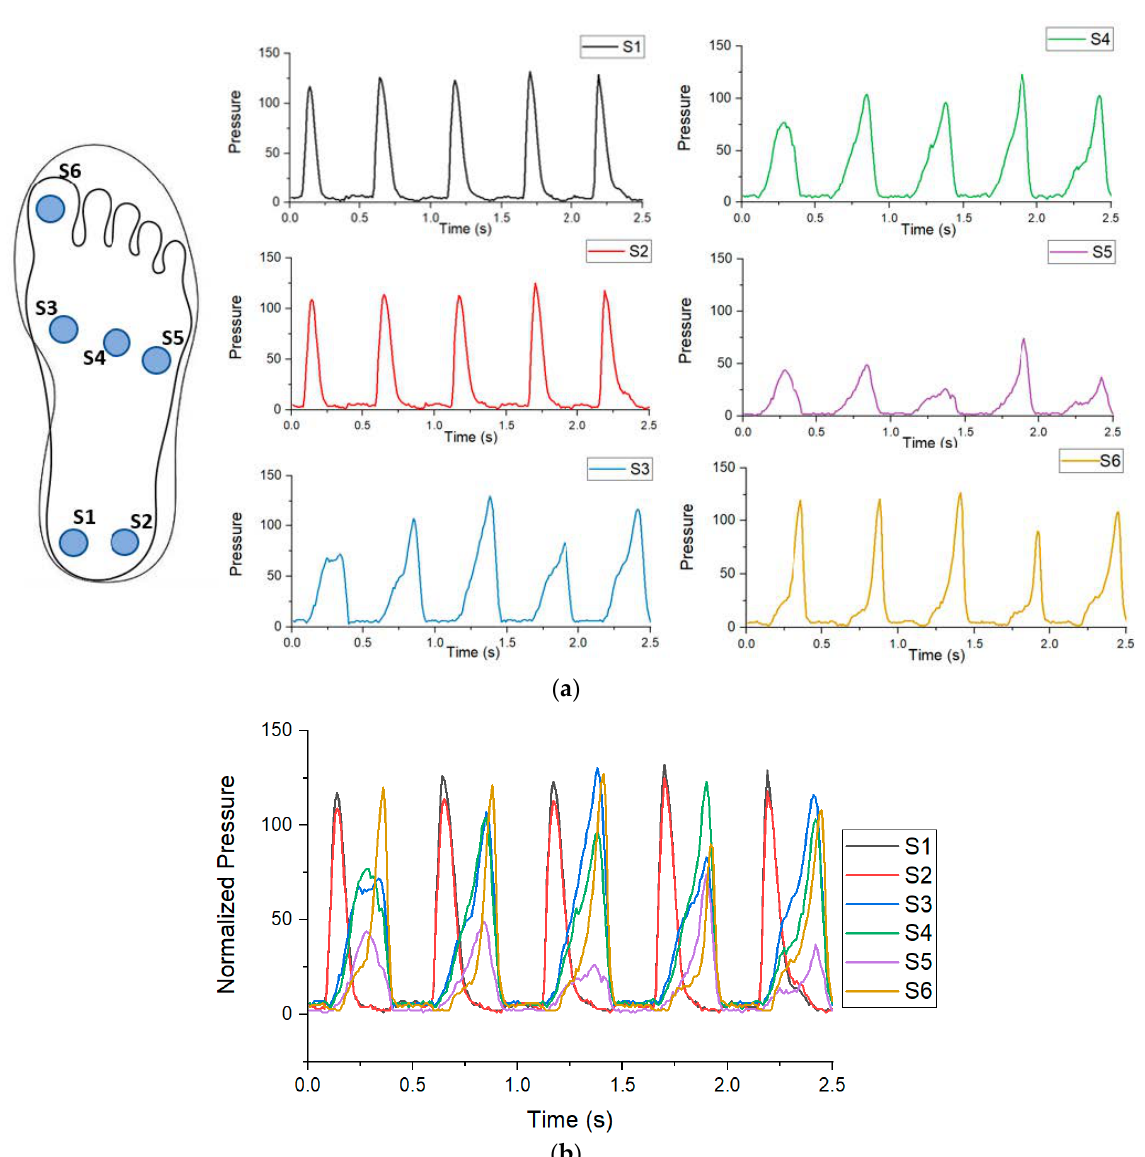
Figure 4. Right foot sensor output for walking: ( a ) pressure outputs of individual sensors; ( b ) combined sensor graph with a complete output of the insole.